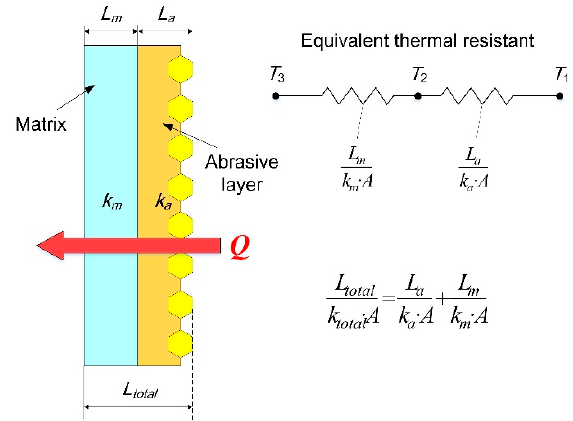
Figure 5. Thermal conduction through the abrasive layer.